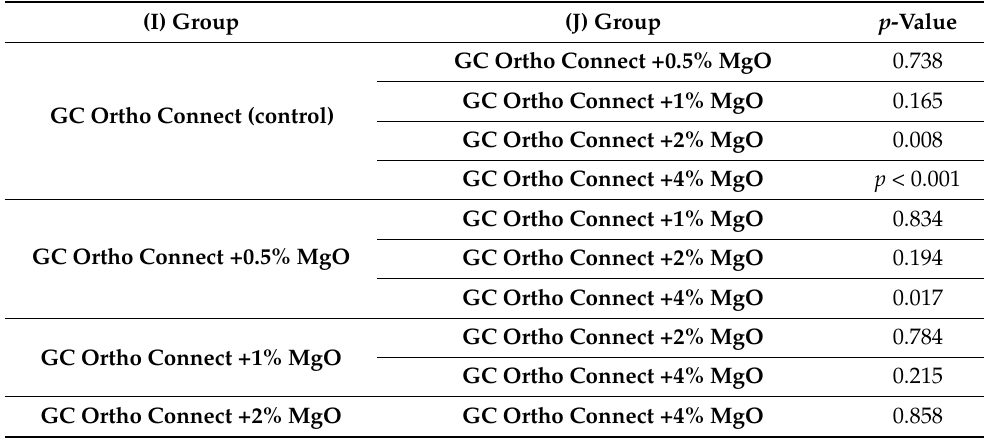
Table 2. Mean and standard deviation of the SBS in five different groups.